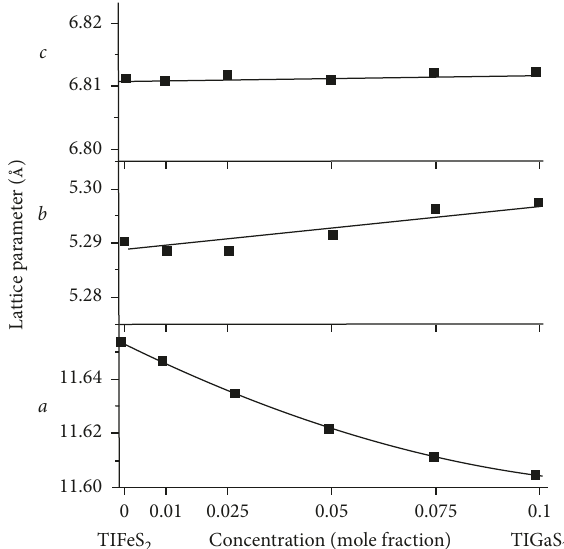
Figure 2: Dependence of lattice parameters of the unit cell ( a , b , c ) of TlFe 1 − x Ga x S 2 samples on the composition. T � 298K.